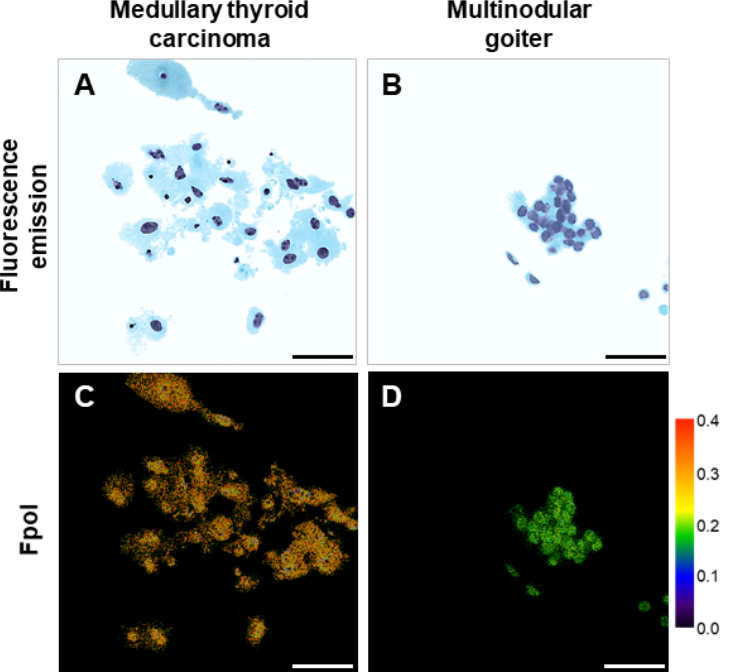
Figure 3. Malignant and benign samples. Example MB fluorescence emission images for ( A ) MTC sample (subject 1) and ( B ) MNG sample (subject 17); ( C , D ) corresponding pseudo-colored MB Fpol images. Scale bar: 50